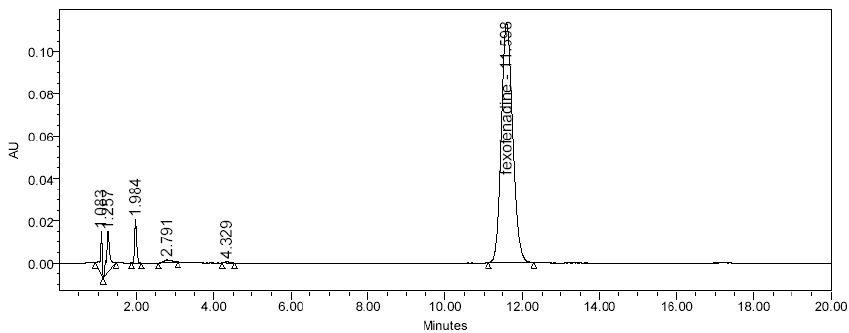
Figure 3. Chromatogram of base-treated fexofenadine. Chromatogram of base (1 N NaOH) hydrolyzed fexofenadine at 80 o for 1 h showing degradation peaks at retention time (T ) 1.237 min, 1.984 min, 2.791 min, 4.329 R